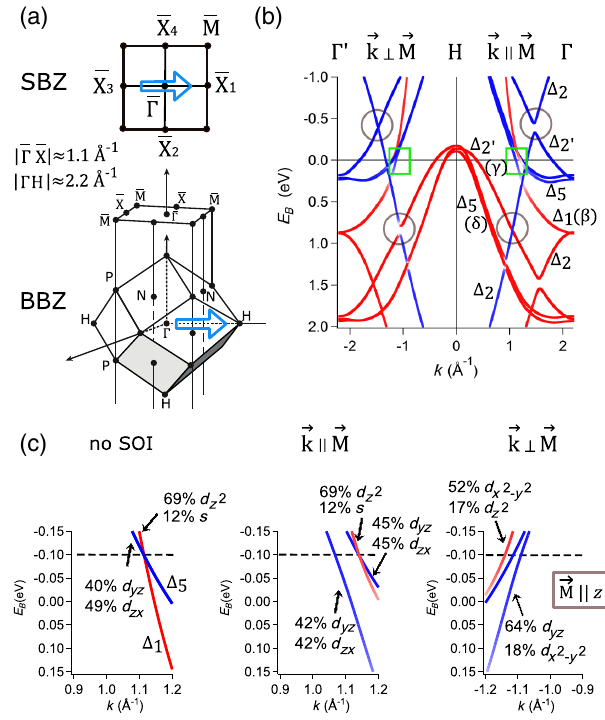
FIG. 2. (a) Bulk and (001) surface Brillouin zones of bcc Fe. ¯ ¯ High symmetry points X 1 to X 4 are defined with respect to the magnetization direction depicted by an arrow. (b) Relativistic bulk band structure of bcc Fe, calculated along the H- Γ (positive k ) and H- Γ 0 (negative k ) using the GW method. Circles mark band crossings or SOG mentioned in the text. Green rectangles mark regions enlarged in (c). (c) Place of interest near k ¼ 0 . 5 j Γ -H j , close to the Fermi level [shown by green rectangles in (b)], where three bands cross in a magnetization-dependent manner. The left panel shows the nonrelativistic situation (no SOI), in the center ~ panel the k vectors are parallel to M, and the right plot shows k ~ vectors perpendicular to M. Blue (red) lines indicate predomi- ~ nantly minority (majority) spin. The magnetization ( M) is parallel to the z axis. The horizontal dashed line marks the position of the experimental Fermi